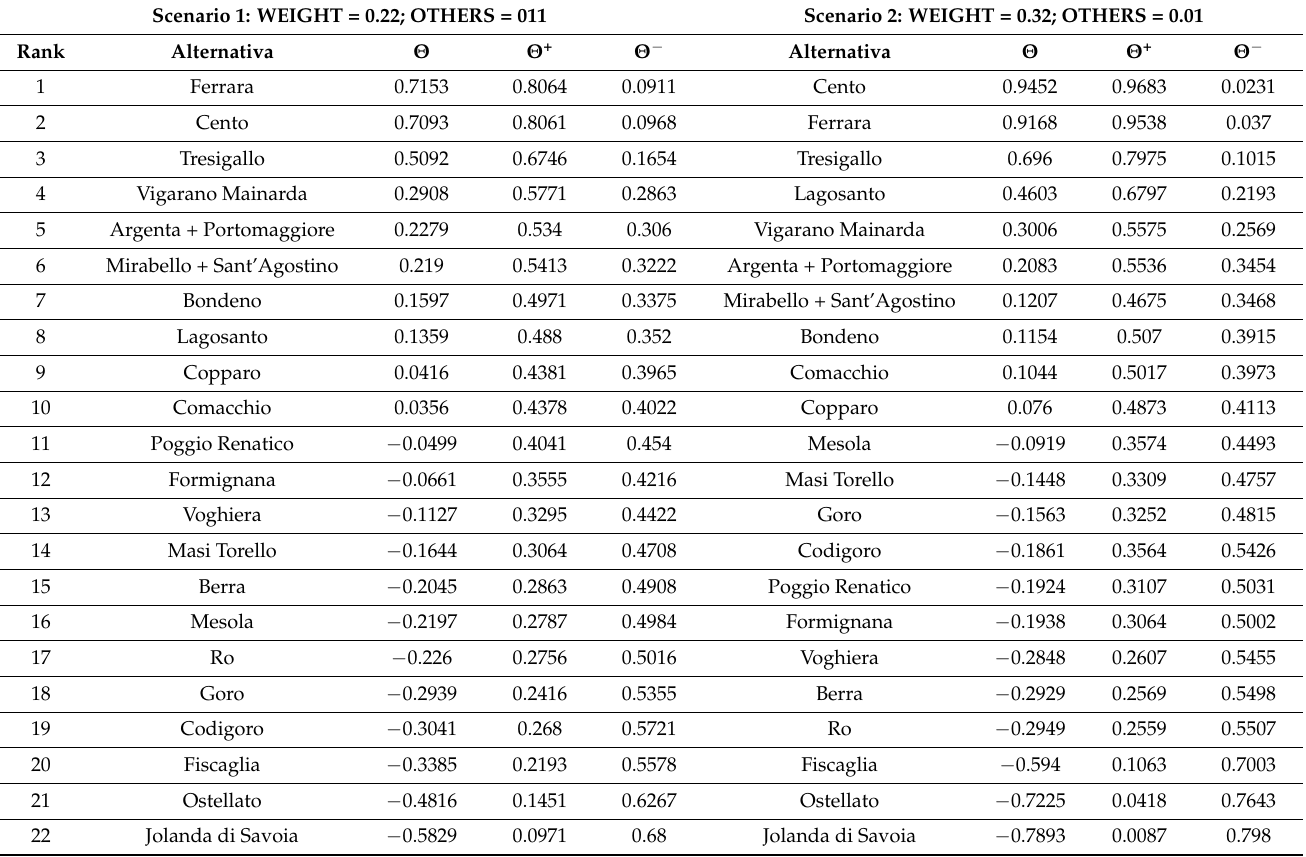
Table 7. Sensitivity analysis on the exposure factor, ranking of alternatives (EXP: